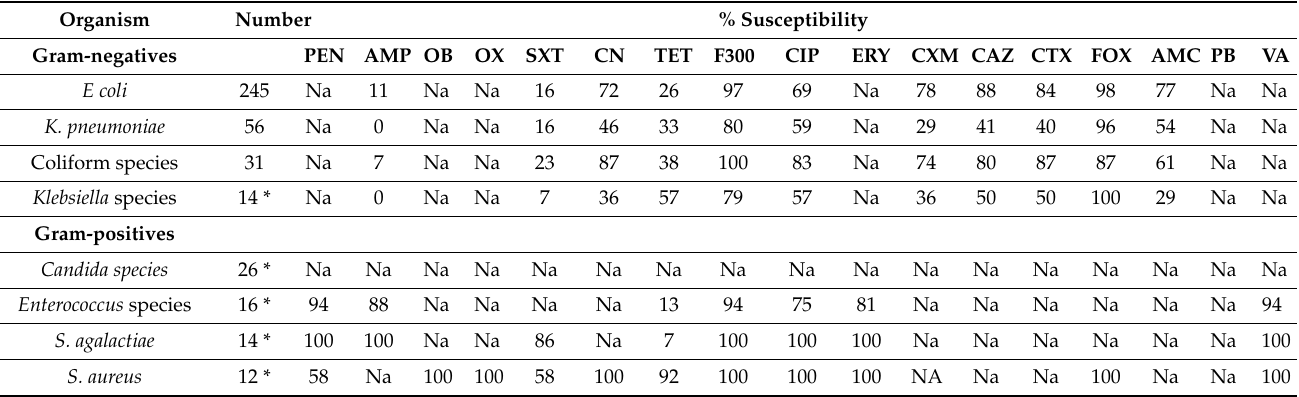
Table 2. Susceptibility profile for the urine